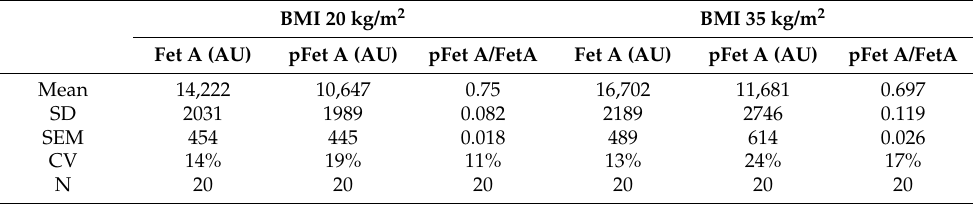
Figure 3. Assay variations of two subjects with different BMI. Representative Western blots of Fet A, pFet A and overlay from two plasma samples from subjects with ( A ) BMI of 20 kg/m 2 and ( B ) BMI of 35 kg/m 2 . To evaluate precision of the analysis 23 samples of each individual were run in one assay. For evaluation of the assay variation the last 3 lanes were not included for the calculation of variation because of unproper run of these samples. Western blot analysis and densitometric evaluations were performed as described in the Method section. m.w.m = molecular weight marker. Table 2. Evaluation of assay variation of the densitometric analysis of Western blots from Figure